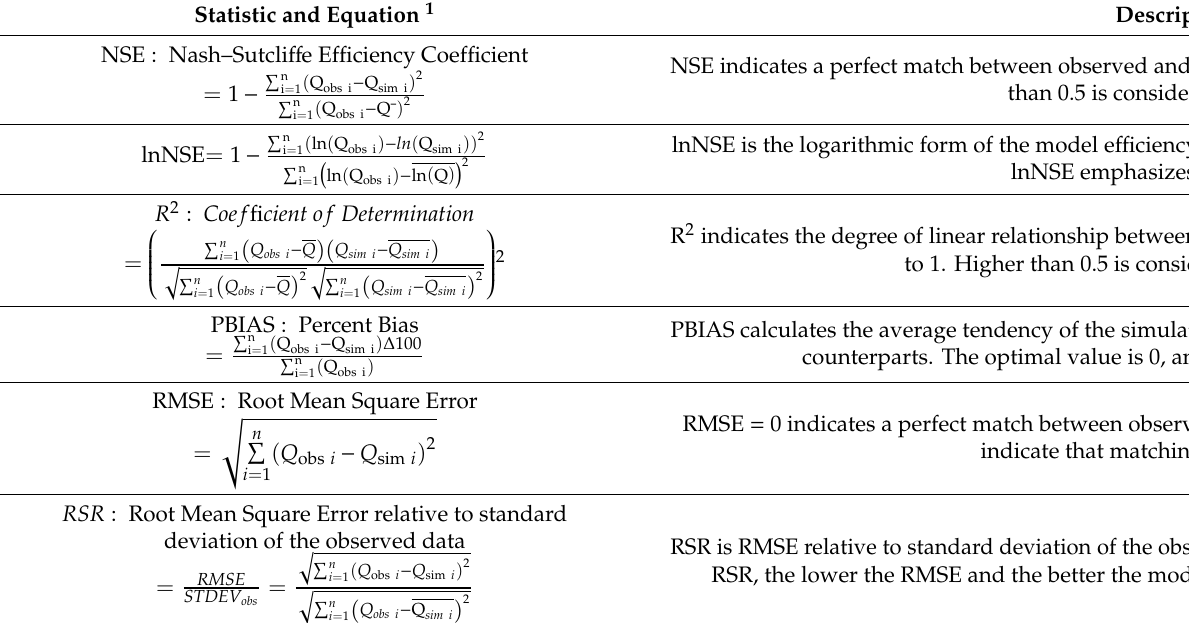
Table 1. Equations, ranges, and optimal values for SWAT model performance statistics, after Moriasi et al. (2012)